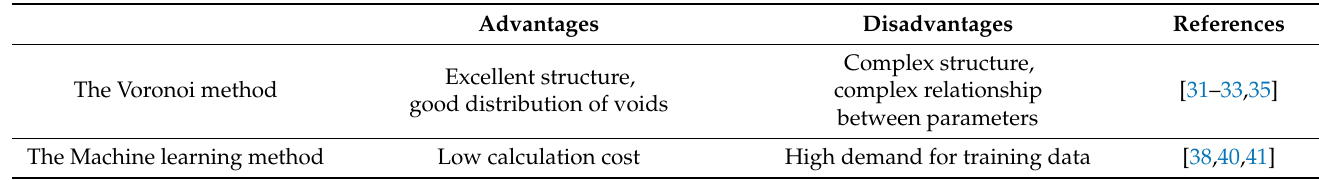
Table 1. Comparison of different optimization